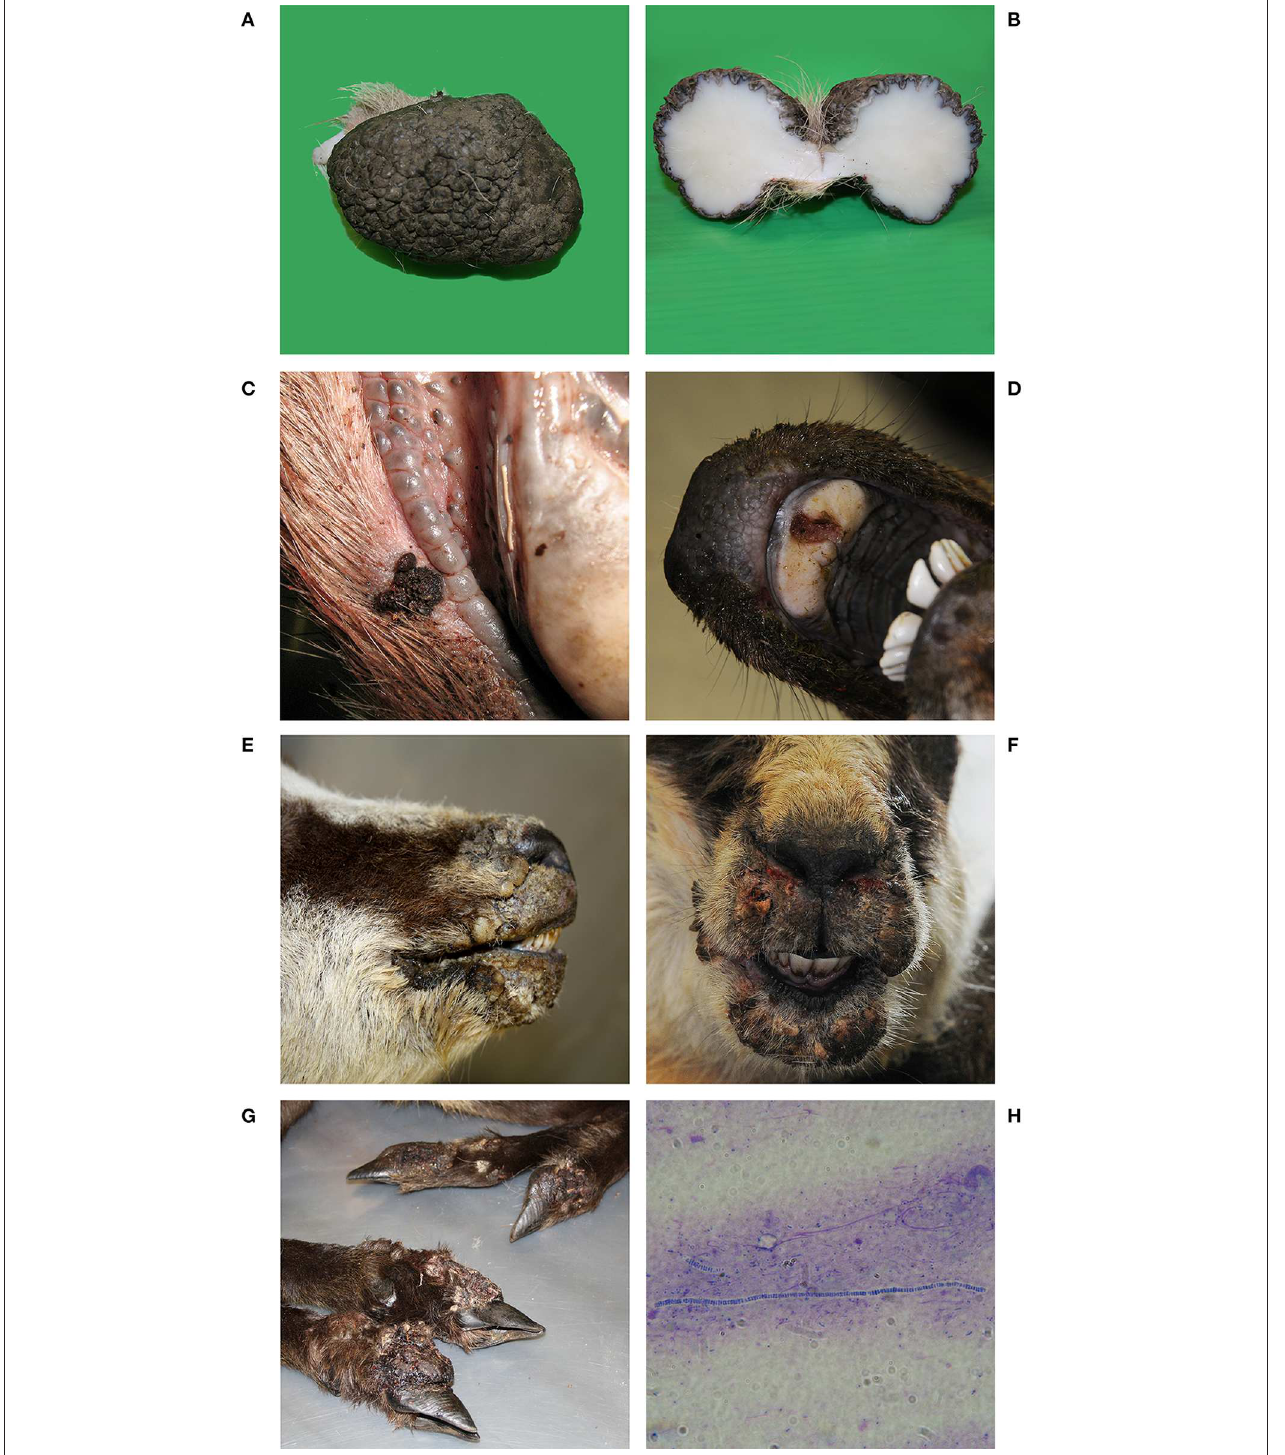
FIGURE 1 | Red deer N ◦ 1635. (A) Pedunculated, oval cutaneous neoformation of dimensions 7 × 5 × 5cm. Hyperkeratotic, glabrous, black, irregular, and fissured surface. (B) When cut, lardaceous consistency, white color and uniform, regular appearance. (C) Red deer N ◦ 1126D and (D) Red deer N ◦ 523. Proliferative lesions, erosions, and ulcers on the lips and on the hard palate. (E) Chamois N ◦ 522 and (F) Chamois N ◦ 520. Ulcerative and crusting lesions on the mucocutaneous tissues of the head: Chamois N ◦ 375. (G) Severe proliferative pododermatitis of all four limbs with coronary hyperplasia. (H) Microscopic detection of Dermatophilus congolensis . Gram staining,